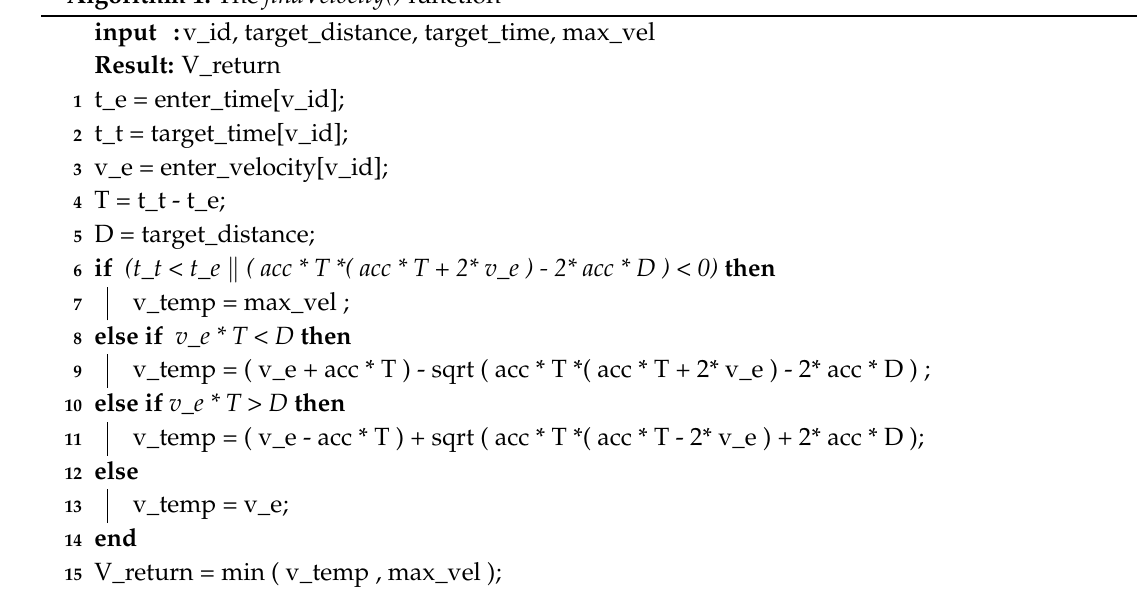
Algorithm 1: The findVelocity()